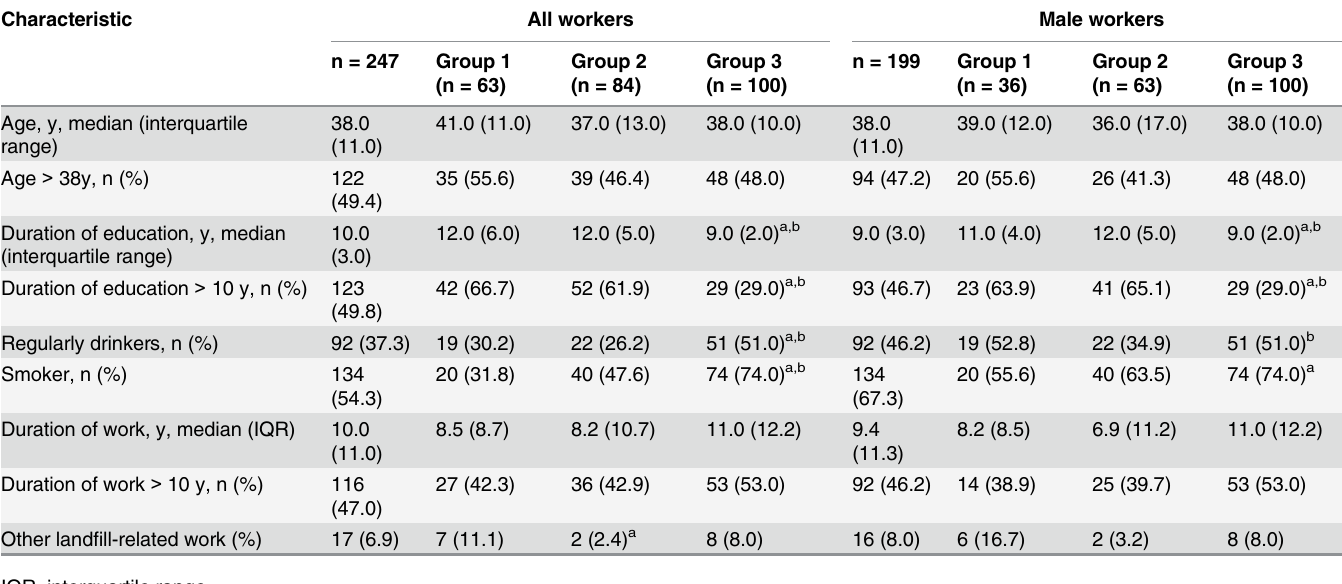
Table 1. Selected characteristics of the cross-sectional study of MSWL workers.